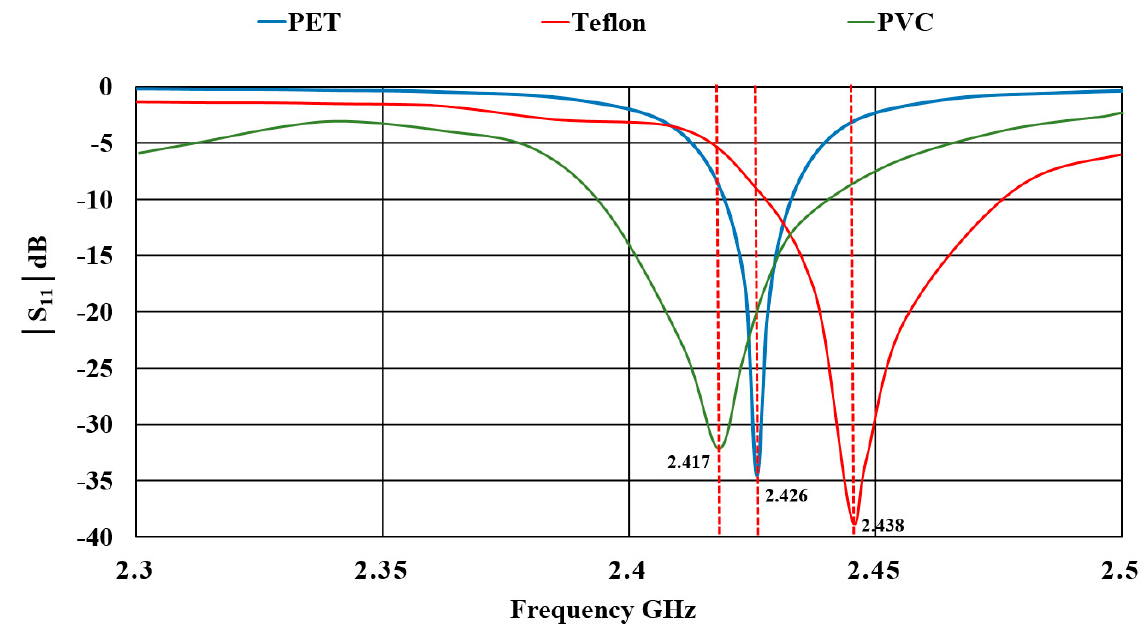
Figure 8. Testing arrangements in the Frankonia anechoic chamber.